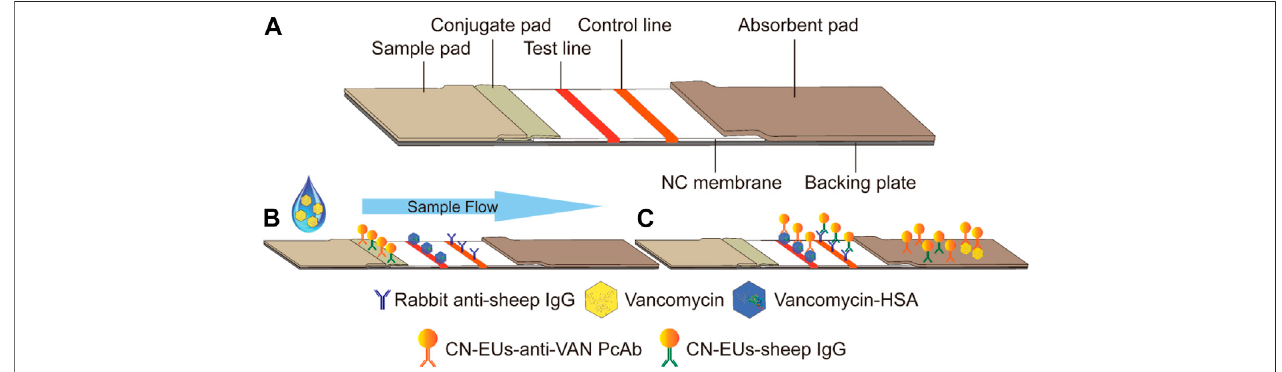
FIGURE 2 | Schematic illustration of the CN-EUs-based LFIA. (A) Pattern diagram of CN-EUs-based lateral fl ow test strip. (B) The conjugated VAN-HSA and the anti-SIgGareimmobilizedonthetestlineandthecontrolline,respectively.SamplescontainingVANareaddedtothesamplepadsandmigratealongtheNCmembrane by capillary action, (C) and the VAN-HSA competes with the VAN in the sample for binding to the anti-VAN PcAbs.